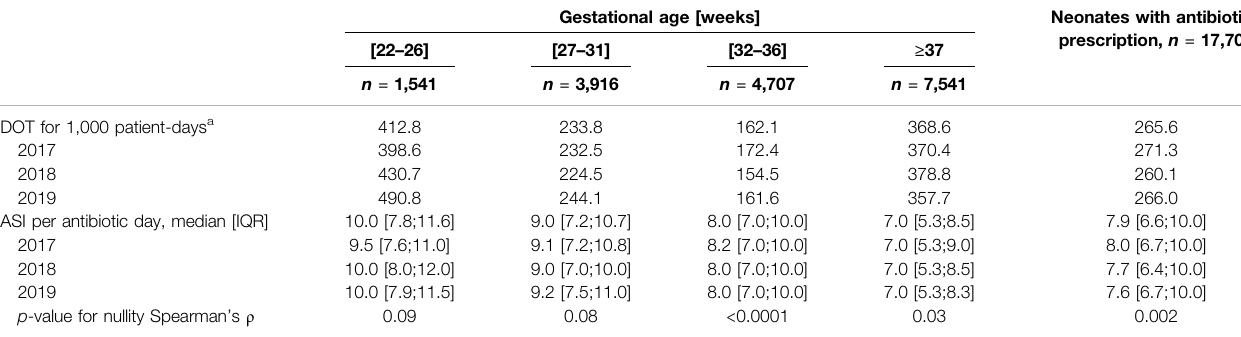
TABLE 4 | Practice of antibiotics prescription by year of admission of